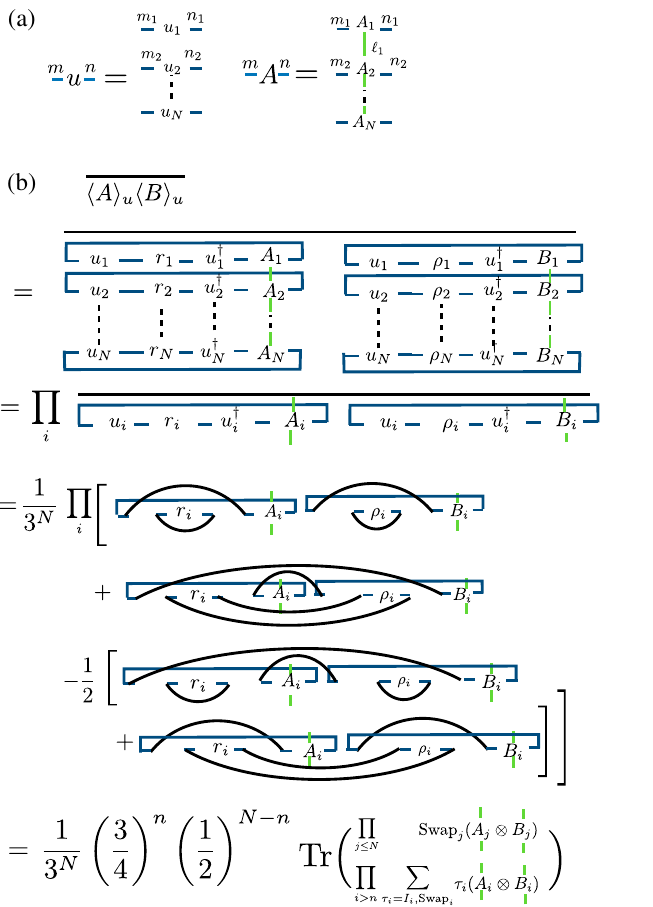
FIG. 8. Identities for our protocol with local unitaries. (a) MPO representation of multisite indexed operators. (b) Correlations between two measurements with A ¼ W ð t Þ , B ¼ V † W ð t Þ V .